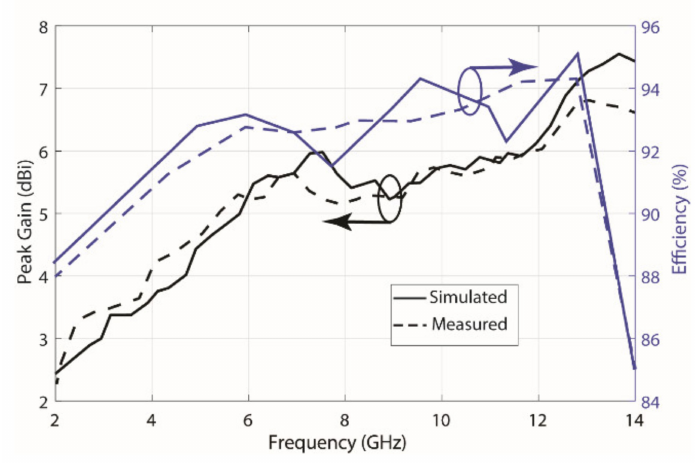
Figure 10. Peak Gain and efficiency of the MIMO